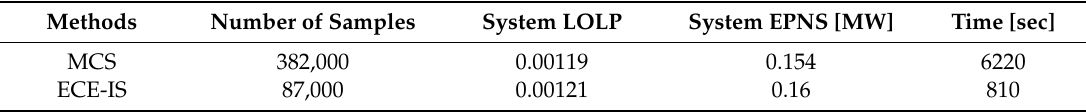
Table 3. System adequacy indices for IEEE-RTS